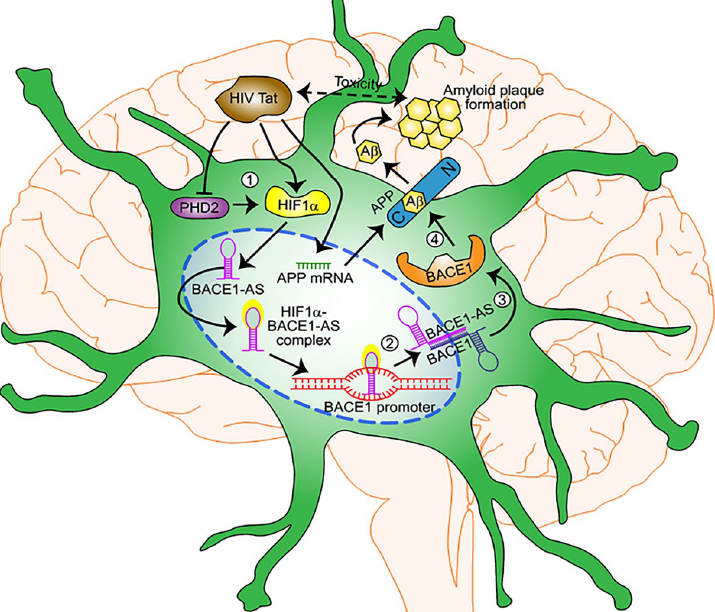
Fig 12. Schematic representation of HIV-1 Tat–induced astrocytic amyloidosis mediated by HIF-1 α –lncRNA BACE1-AS axis. HPAs exposed to HIV-1 Tat showed increased expression and accumulation of HIF-1 α involving differential regulatory mechanisms—transcription, RNA stabilization (posttranscription), translation, and posttranslational stabilization (decreased expression of PHD-2) (1). Upon accumulation, HIF-1 α is translocated into the nucleus, where it forms a complex with the lncRNA BACE1-AS (which is also up-regulated following HIV-1 Tat exposure).The HIF-1 α –lncRNA BACE1-AS complex, in turn, binds to the BACE1 promoter to induce its transcription (2). Following transcriptional induction of BACE1 mRNA, it subsequently binds to the BACE1-AS, resulting, in turn, in stabilization of BACE1 mRNA (3). This then leads to increased translation and activity of BACE1 (4). Additionally, HIV-1 Tat has also been shown to induce the expression of APP mRNA, resulting in up-regulated expression of APP protein, which then is subject to cleavage by BACE1, leading to the release of various A β forms into the extracellular space. Oligomerization of the toxic A β forms leads to deposition of insoluble amyloid plaques in select brain regions, which are neurotoxic and can also independently interact with HIV-1 Tat to further aggravate HAND-associated toxicity. APP, amyloid precursor protein; A β , amyloid beta; BACE1, β -site cleaving enzyme; BACE1-AS, BACE1- antisense transcript; HAND, HIV-associated neurocognitive disorder; HIF-1 α , hypoxia-inducible factor; HPA, human primary astrocyte; lncRNA, long noncoding RNA; PHD-2, prolyl hydroxylase 2; Tat, transactivator of transcription. Original creation